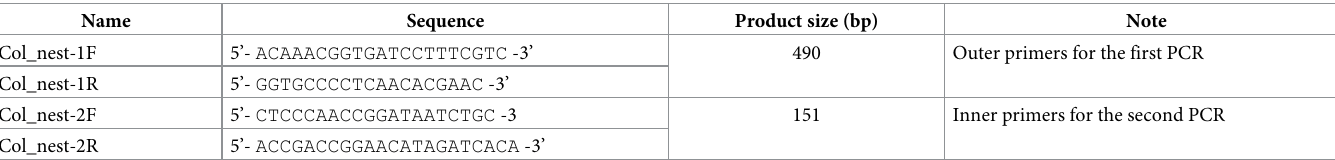
Table 1. Nested PCR primers used in this